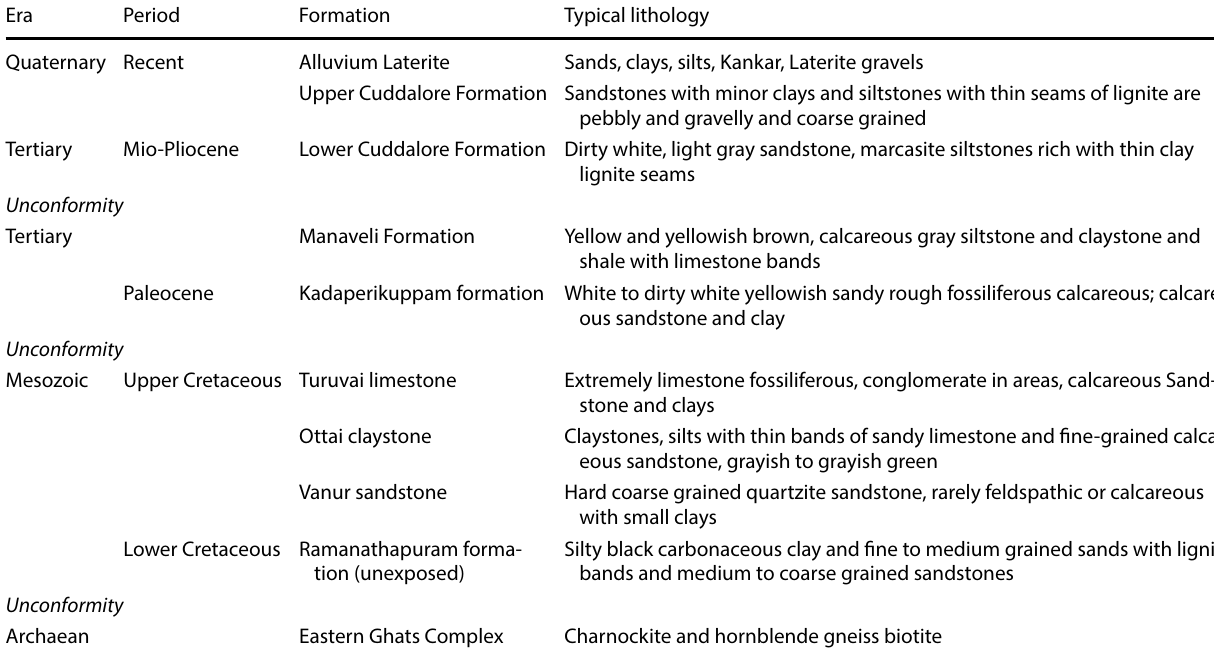
Fig. 1 The geology map of the study area showing the location of the samples collected Table 1 Stratigraphic succession for the study region